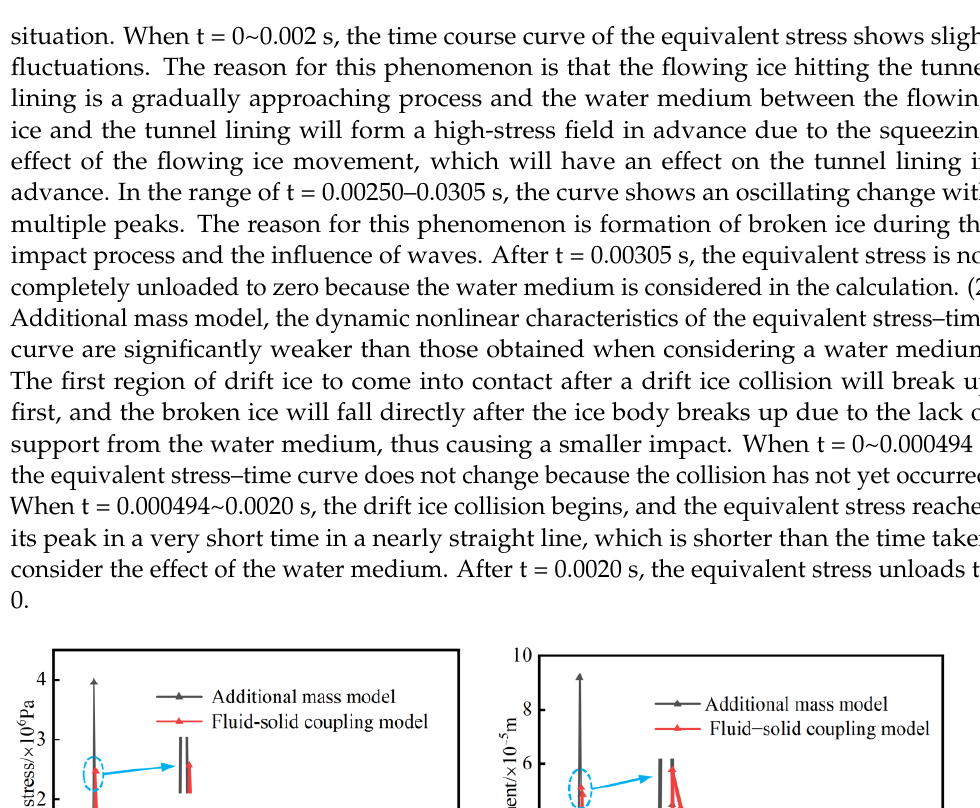
Figure 6. Displacement clouds in X -direction under different collision models, where: Local en-